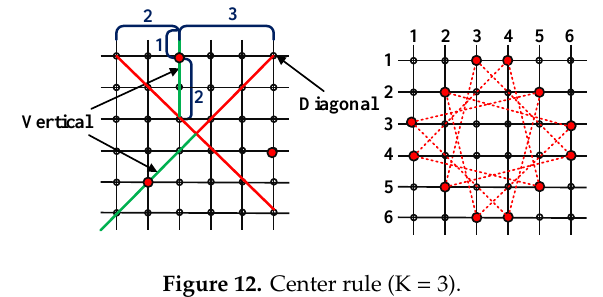
Figure 12. Center rule (K = 3).